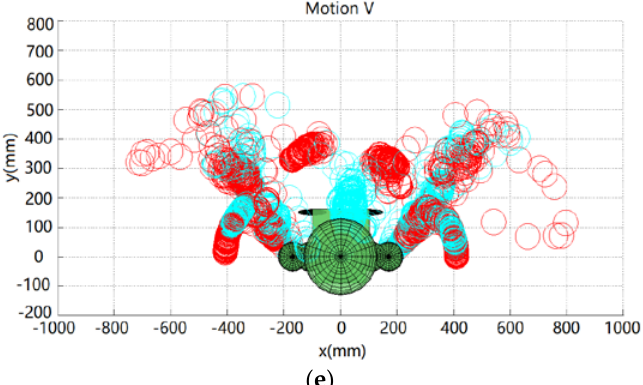
Figure 11. The positions of the robot’s arms for Motions I, II, III, IV and V shown in ( a – e ), respectively. Blue circles and red circles represent the positions determined by the directly mapped and collision-free trajectories, respectively.